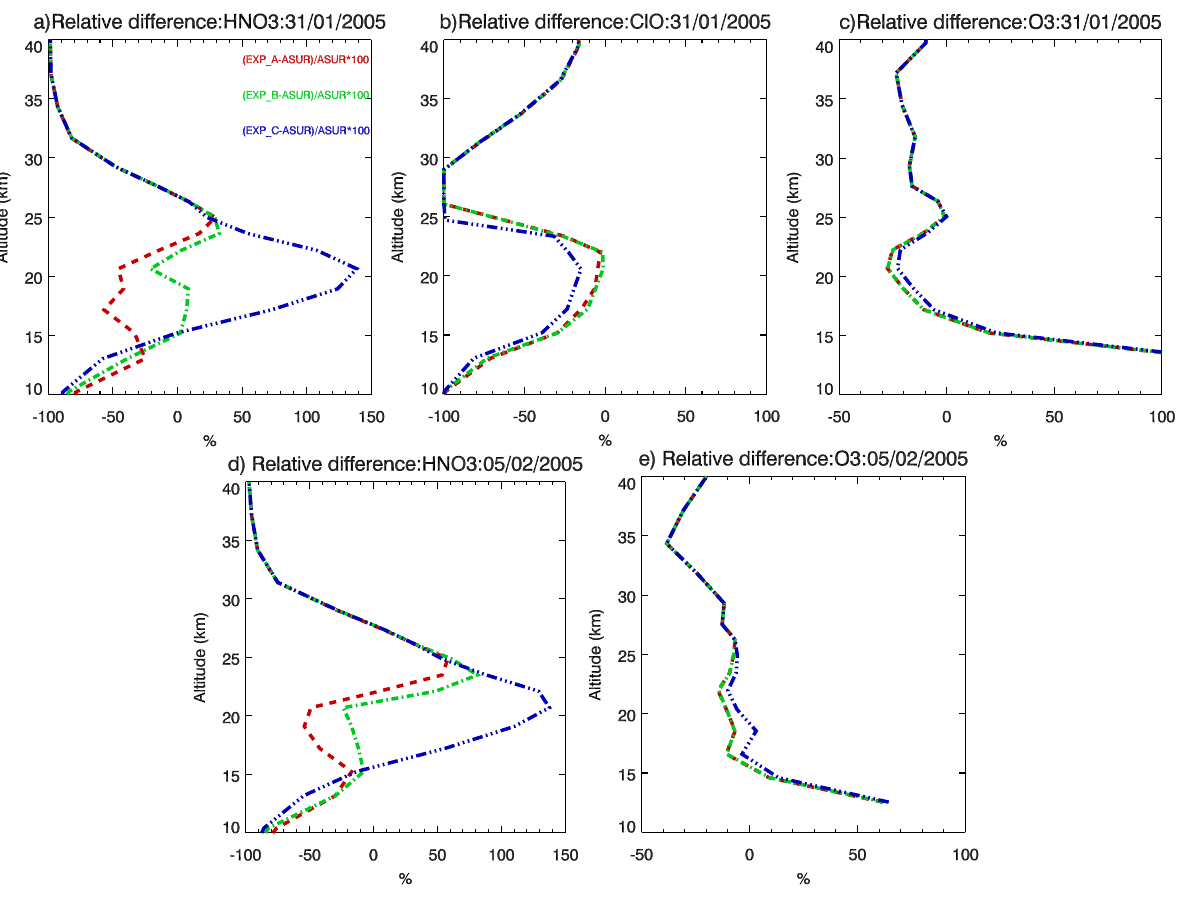
Fig. 3. The relative difference (%) of HNO 3 , ClO and O 3 between ASUR measurements and SLIMCAT full chemistry simulations using the equilibrium (EXP A) and DLAPSE (EXP B) PSC schemes and without denitrification (EXP C) for 31 January and 5 February